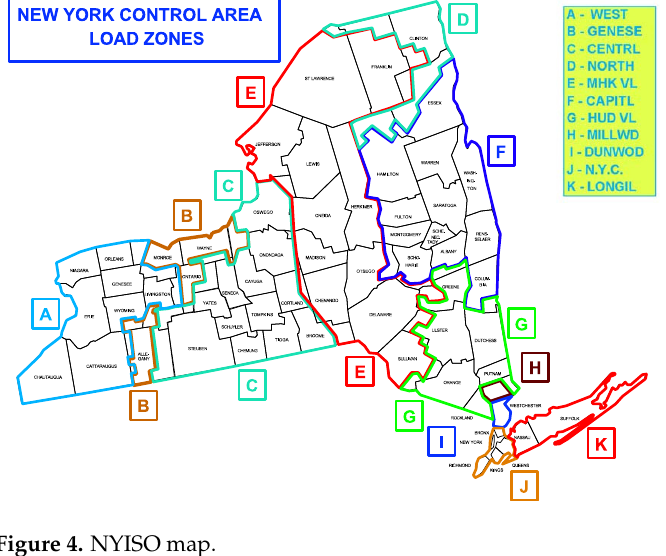
Figure 4. NYISO Figure 4. NYISO map.